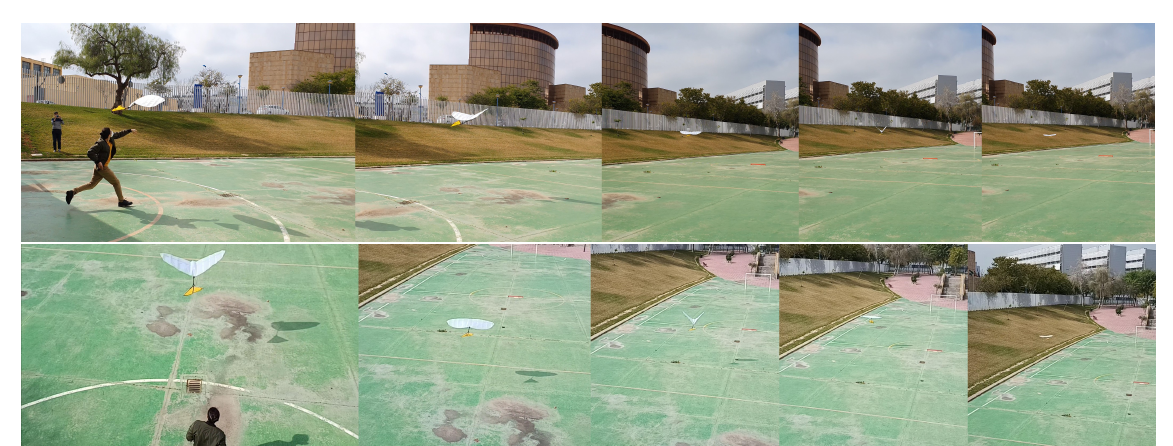
Figure 18. Manually Controlled Straight Flapping-Flight